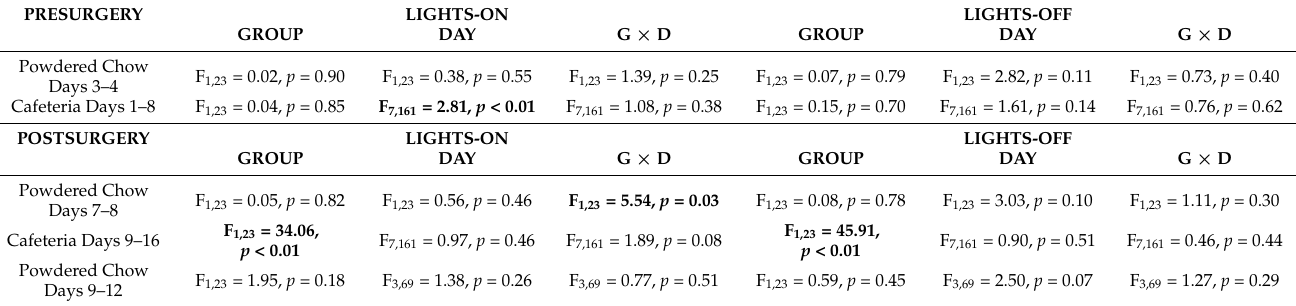
Figure 15. Meal Eating Rate for Meals with Lights On vs. Lights Off. Mean ( ± SE) rate of consumption in kilocalories/minute when lights were on (open symbols) or off (filled symbols) for each day for CTL (combined SHAM and IRON groups, n = 14; orange circles) and RYGB ( n = 11; blue triangles) rats for powdered chow days (PC), acclimation days for each food (Acclim.; CF: chickpea flour; Y: yogurt; PB: peanut butter; SFW: sugar/fat whip), and cafeteria diet days. Dashed vertical lines indicate transitions between diet conditions (thin dashed) and between pre- and post-surgical phases (thick dashed). Statistically significant results from between-group two-way mixed ANOVAs (Table 18) are indicated by the legend; within-group ANOVA results are presented in Table 19. Table 18. Two-way ANOVAs Comparing Meal Eating Rate for Lights-On and Lights-Off Meals between Groups for Each Diet Condition.